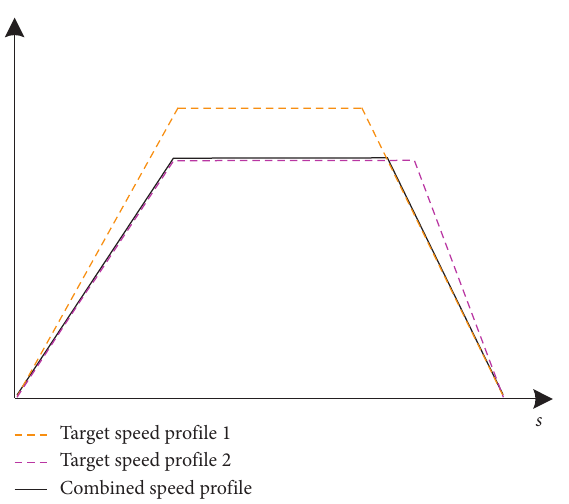
Figure 16: Abstraction of a combined velocity